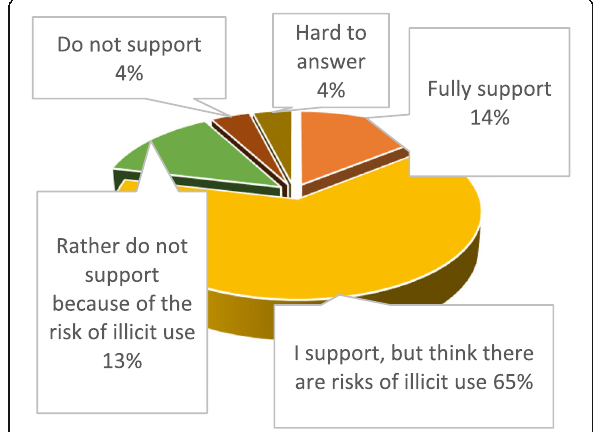
Fig. 3 Ukrainian pharmacy students ’ attitude to legalization of medical cannabis in Ukraine